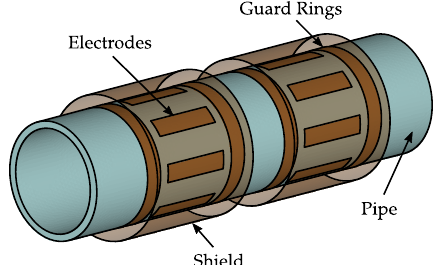
Figure 2. Scheme of a capacitive flow meter for pneumatically conveyed